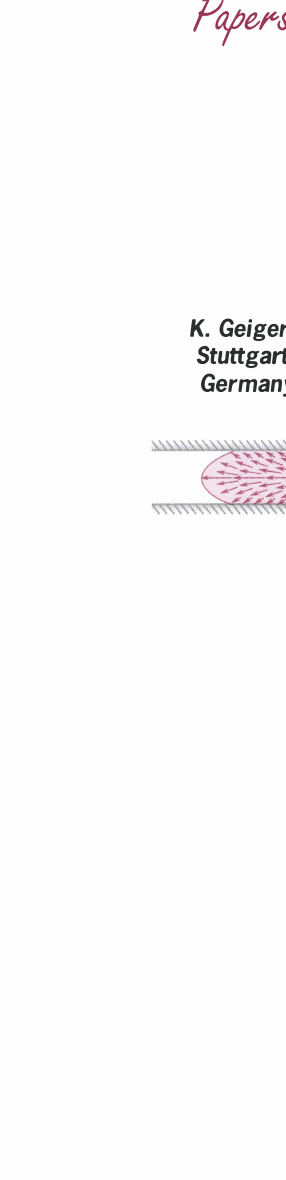
Fig. 1: a) Orientational order of mesogenic units, b) Symmetry elements of the nematic mesomorphic